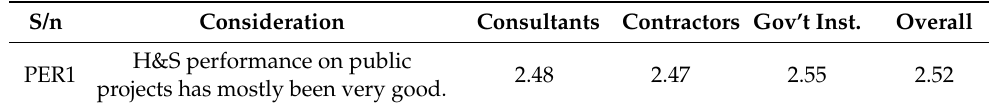
Table 17. H&S performance of public